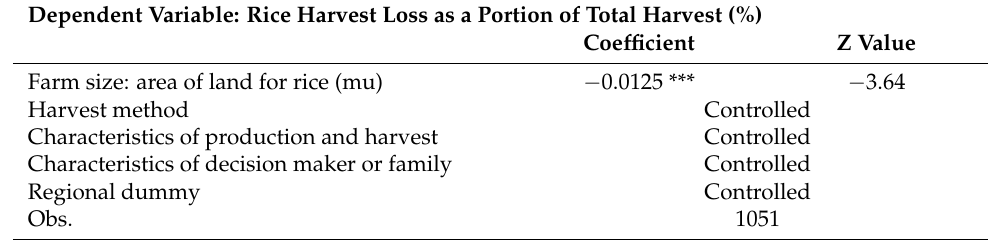
Table 7. Estimation results of the impact of farm size on rice harvest losses (i.e., farmers who adopted agricultural machinery services).